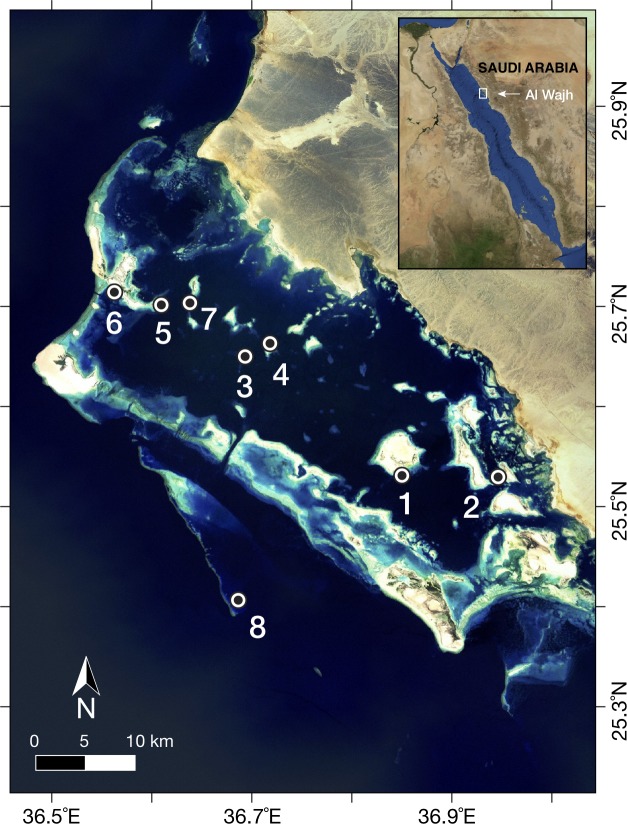
Map of Al Wajh Bank and sites surveyed.Created using ESRI World Imagery basemap. Sources: Esri, DigitalGlobe, GeoEye, i-cubed, USDA FSA, USGS, AEX, Getmapping, Aerogrid, IGN, IGP, swisstopo, and the GIS User Community.